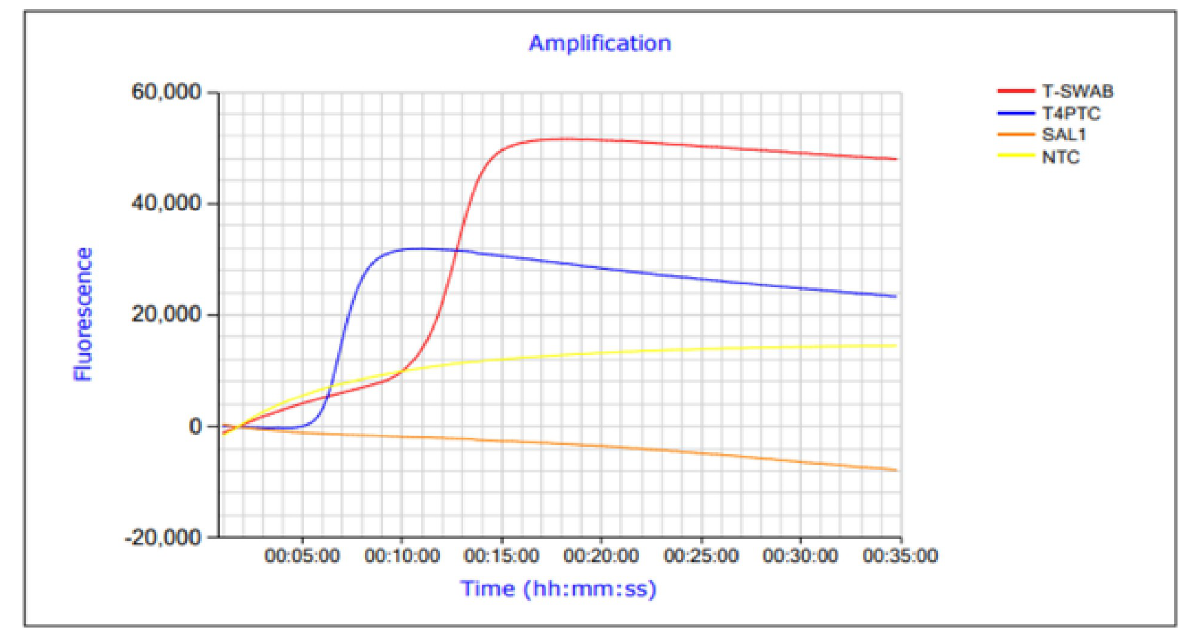
Fig 3. Amplification profile of the Thunnus albacares LAMP assay using MSwab extraction of DNA. T-SWAB = DNA from Thunnus albacares extracted by MSwab method; T4PTC = positive control; SAL1 = DNA from Salmon salar (negative extraction control); NTC = non- template control.